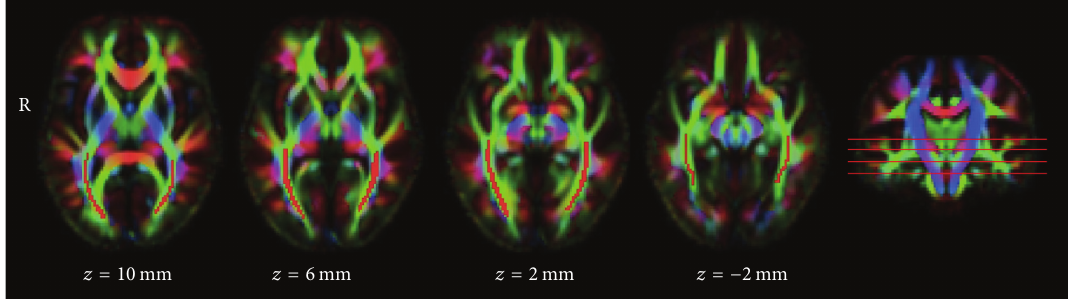
Figure 1: Diffusion tensor imaging template generated from 10 random controls and 10 random patients using DTI-TK. The optic radiation region of interest used to calculate DTI parameters is shown in red against the green background of the optic